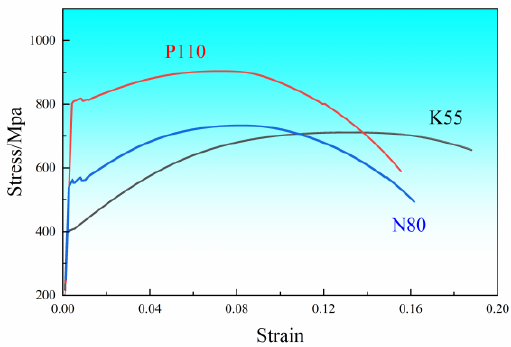
Figure 3. Tensile curves of different casing drilling steel. Table 3. Comparison between the mechanical properties of different steels.